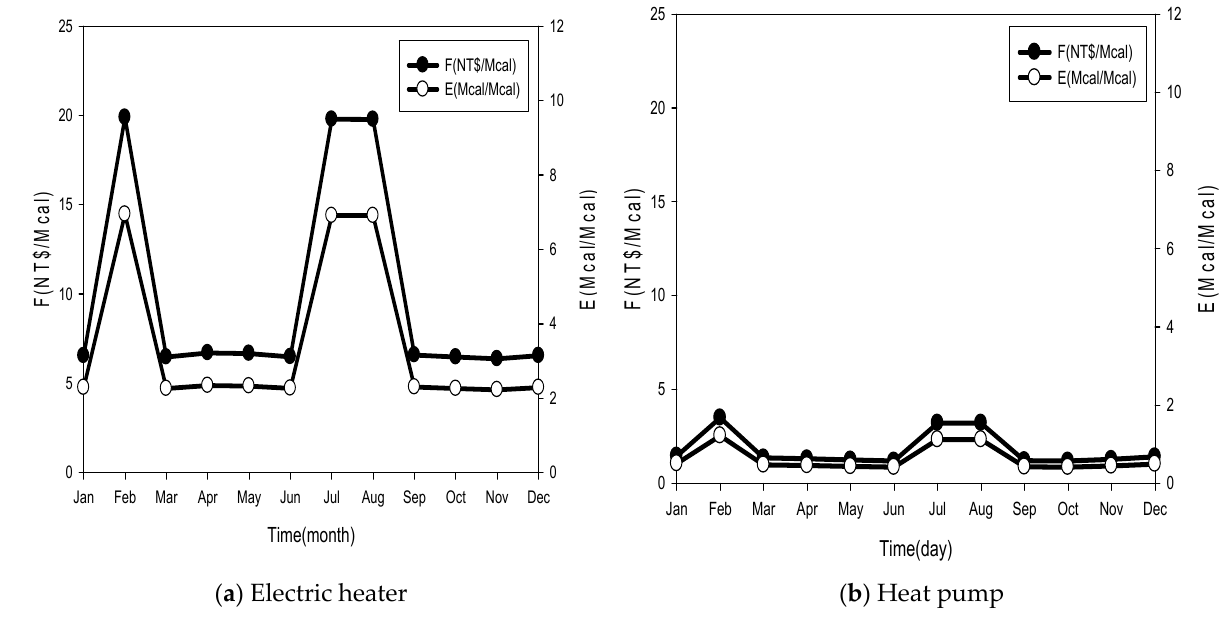
Figure 7. Energy efficiency ratio and energy cost.